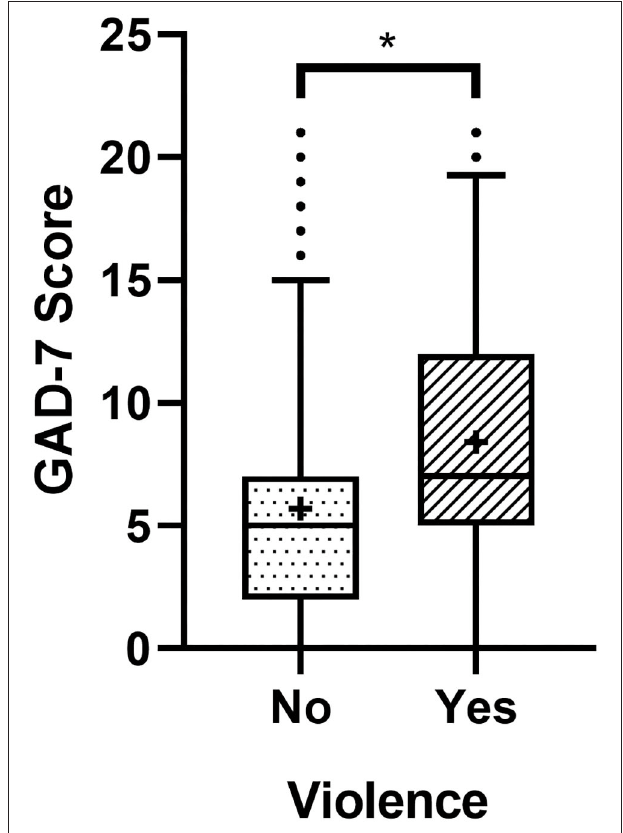
FIGURE 2 | Boxplots showing the GAD-7 scores of the participants who have or not suffered violence during the pandemic. The dots above the superior limit represent the outliers. The crosses inside the boxplots indicate the score average of their respective group, and * indicates difference between the groups ( p < 0.01).